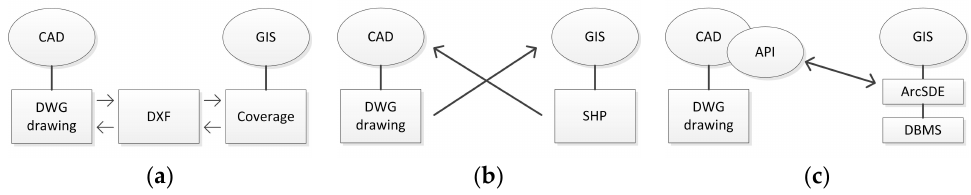
Figure 2. Three kinds methods of CAD (Computer Aided Design) data to Geographic Information System (GIS). ( a ) Description of file conversion; ( b ) Description of direct access; and, ( c ) Description of sharing interface of database.